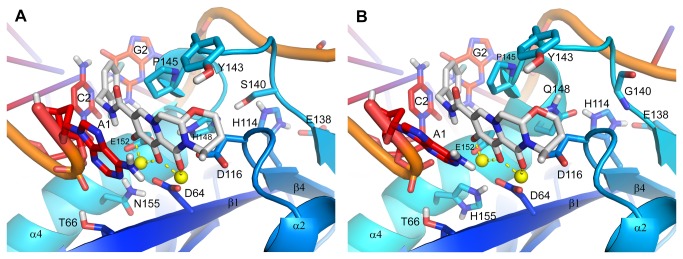
Structural models of (A) Q148H/G140S and (B) N155H HIV-1 integrase with U5 LTR DNA and dolutegravir.(A) The Q148H/G140S mutations are predicted to disrupt the structure of the flexible active-site loop, displacing the 310 helix away from the DDE motif and weakening the H-bond interaction between the backbone CO of Q148H and the backbone NH of E152. (B) The N155H mutation is predicted to disrupt the structure of the α4 helix, widen the base of the catalytic pocket, alter the placement of at least the Mg2+ ion coordinated to residues D64 and E152 and alter the conformation of the terminal 3′ adenosine forming part of the pocket. Molecular representations and coloring schemes are described in Figure 2.